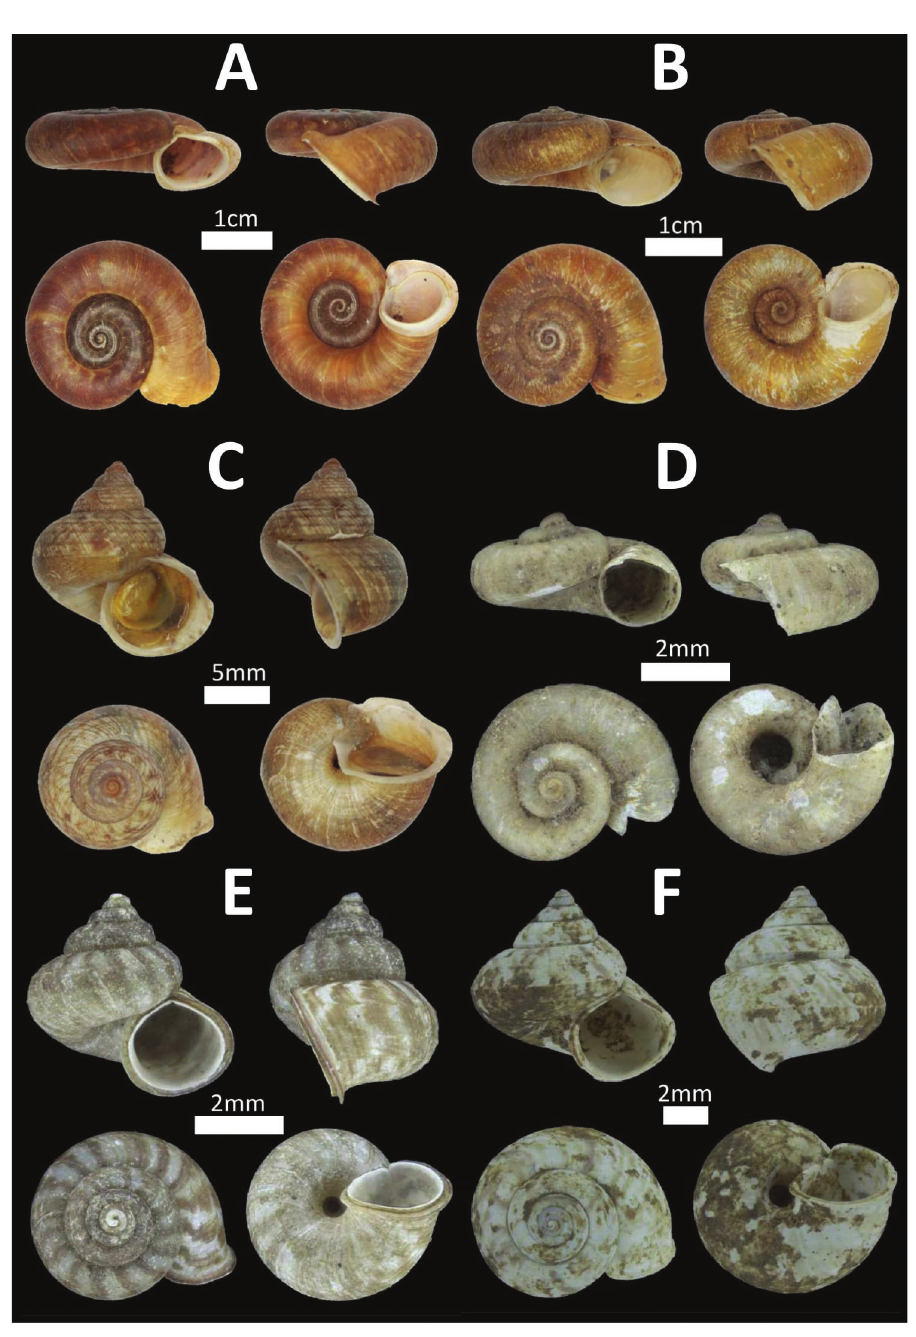
Figure 3. Family Cyclophoridae. A Pterocyclos tenuilabiatus (BOR/MOL 105) B Pterocyclos amabilis (BOR/MOL 8850) C Leptopoma pellucidum (BOR/MOL 6780) D Platyraphe bongaoensis (BOR/MOL 7185)*Broken aperture E Japonia trilirata / kinabaluensis species complex (BOR/MOL 12267) F Japonia balabacensis (BOR/MOL